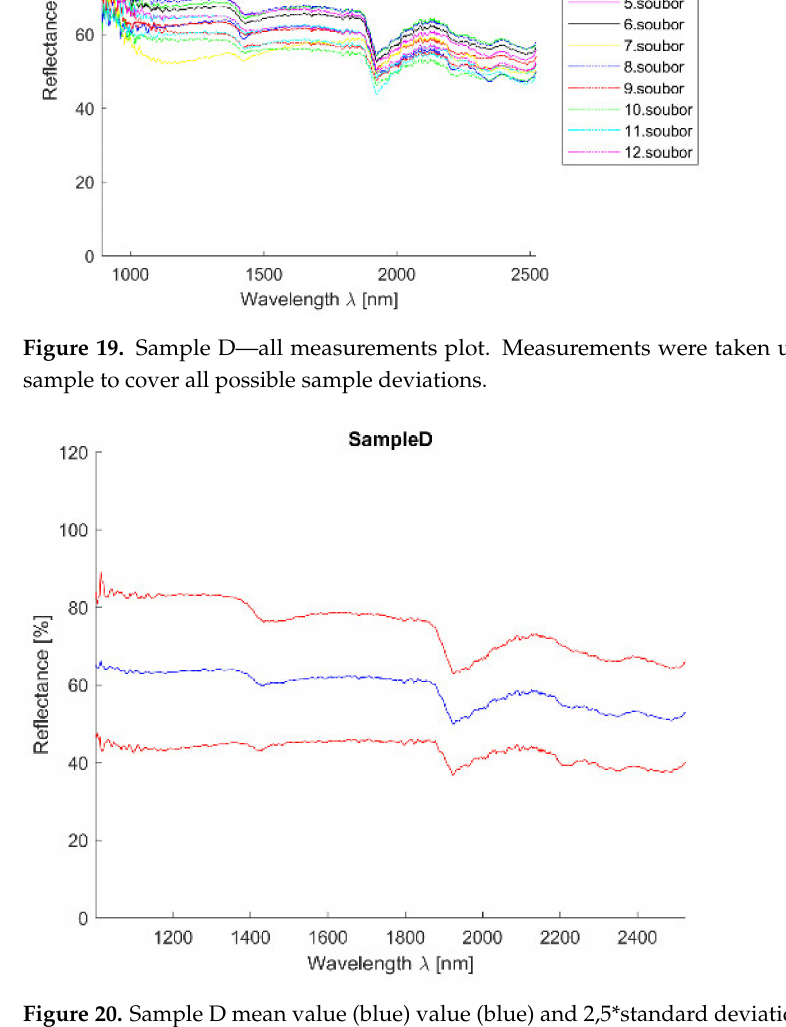
Figure 20. Sample D mean value (blue) value (blue) and 2,5*standard deviation